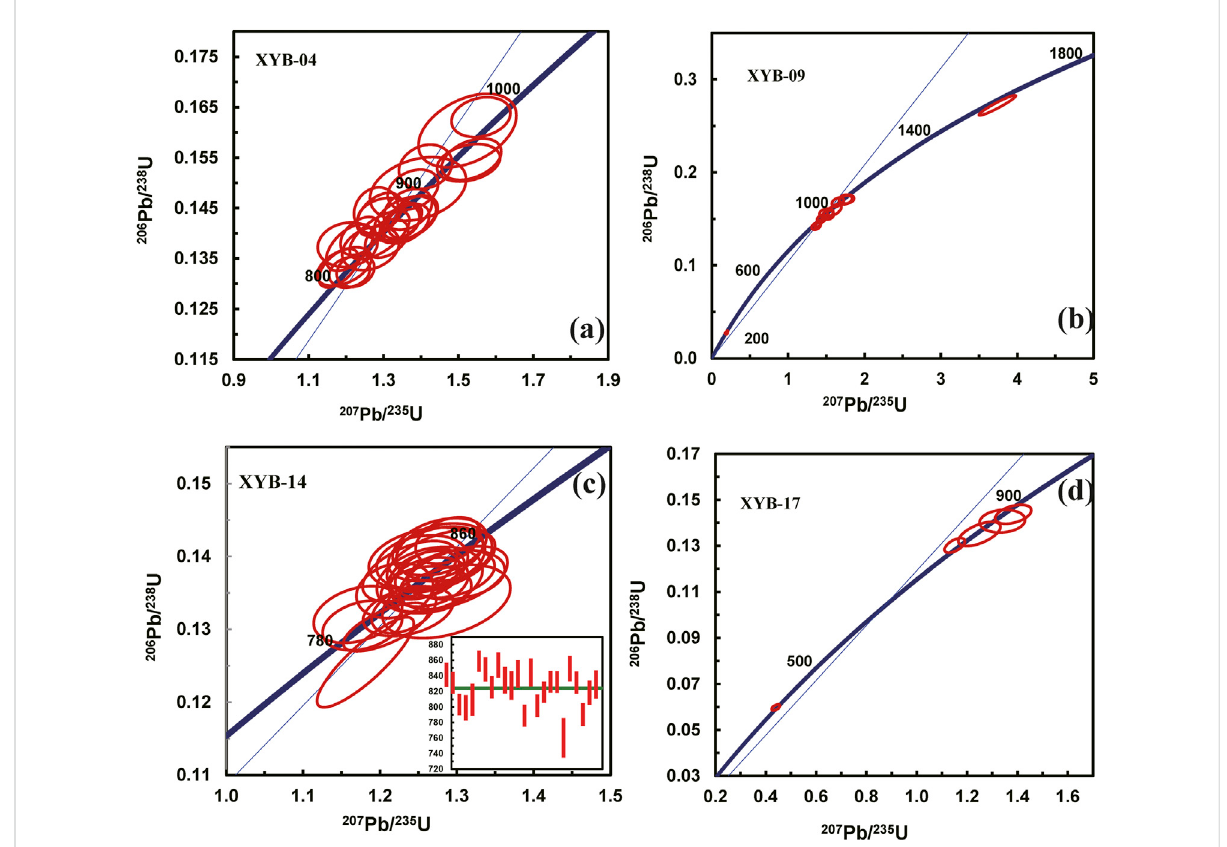
FIGURE 10 U-Pb age concordance of zircons of schist for (A) XYB-04; (B) XYB-09; (C) XYB-14; (D)